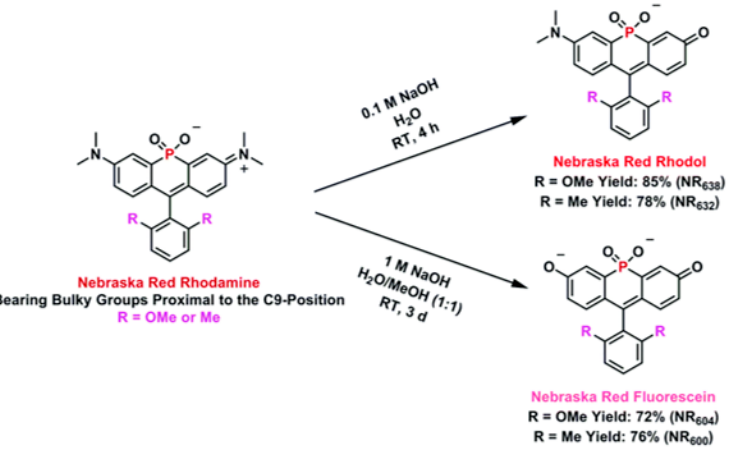
Figure 28. Direct transformation of NR rhodamine to NR rhodol or NR fluorescein. Adapetd with permission from [297].